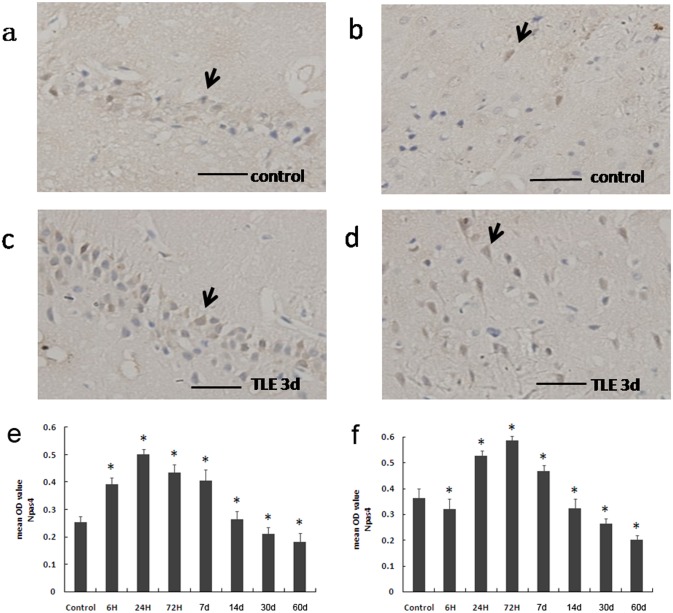
Immunohistochemistry showed immunoreactive staining of Npas4 in the hippocampi (a) and adjacent cortices (b) of the normal control rat brains.Immunohistochemistry of Npas4 showed strong immunoreactive staining in the hippocampus (c) and adjacent cortex (d) at 72 h after kindling. The black arrowheads indicate Npas4-positive cells. (e) A comparison of the mean OD value between the epileptic and normal rats. The mean OD value indicated that Npas4 expression in the hippocampi of the rats increased at 6 h after the pilocarpine-induced seizure. The highest level of Npas4 expression occurred at 24 h and then began to decline, reaching its lowest level at 30 d. The Npas4 expression levels differed significantly between normal and epileptic rats between 6 h and 30 d after kindling (*P<0.05). (f) A comparison of the mean OD values between epileptic and normal rats. The mean OD value indicated that Npas4 expression in the adjacent cortices of the rats increased at 24 h after pilocarpine-induced seizure and reached its highest level at 72 h. The lowest level of Npas4 expression occurred at 60 d. There were significant differences in Npas4 expression levels between the normal and epileptic rats from 6 h to 60 d after kindling (*P<0.05).